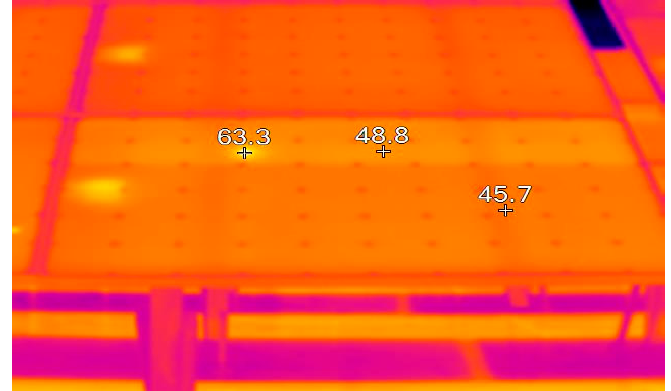
Figure 5. IR images of bypass diode failure in the field (Ti27, FLUKE Co, Ltd.).